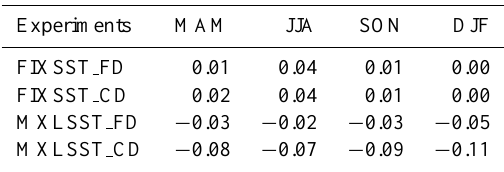
Table 3. Simulated dust-induced global mean changes in SAT in different seasons. Units: